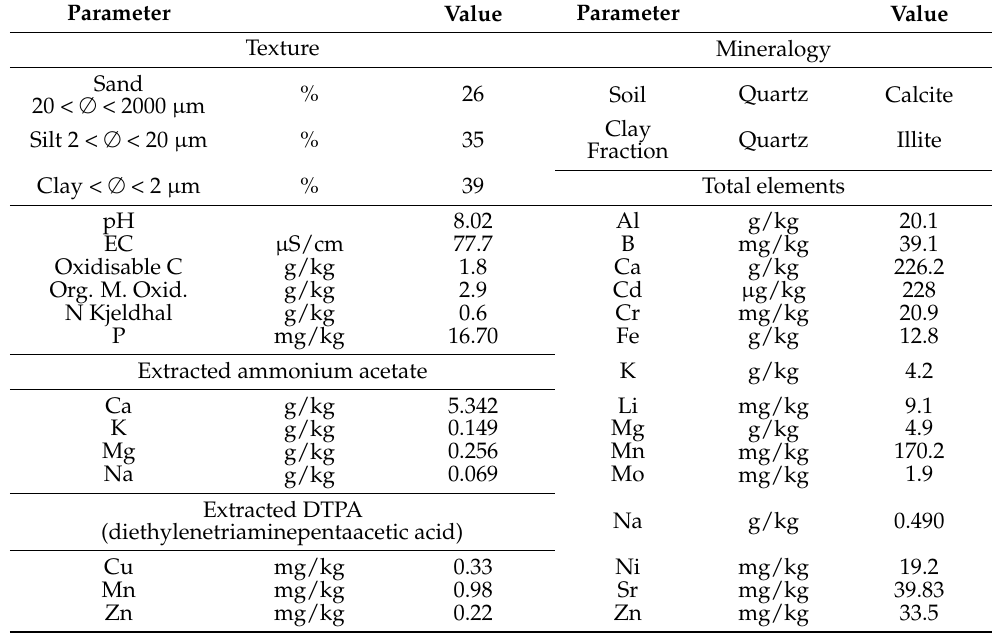
Table 1. Characteristics of the soil used in the study.